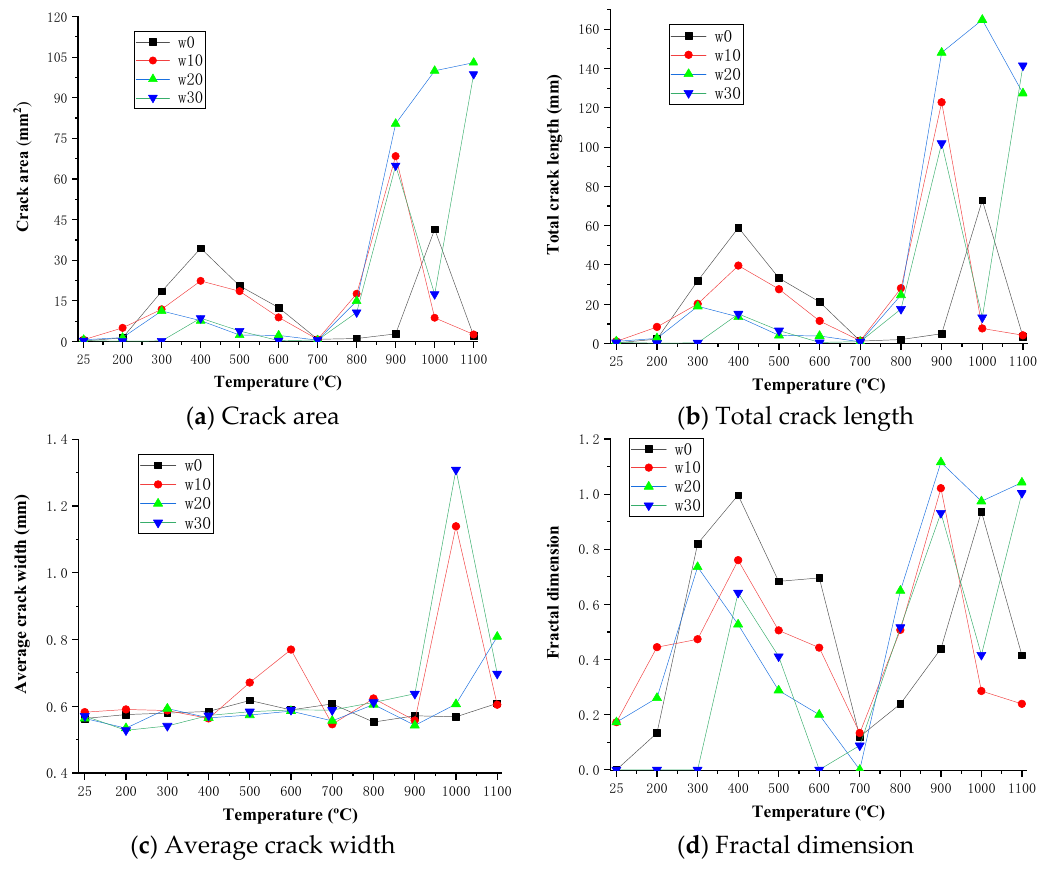
Figure 6. Surface crack parameters variation curves with temperature of the prism specimen (( a ): crack area curve; ( b ): total crack length curve; ( c ): average crack width curve; ( d ): fractal dimension curve).